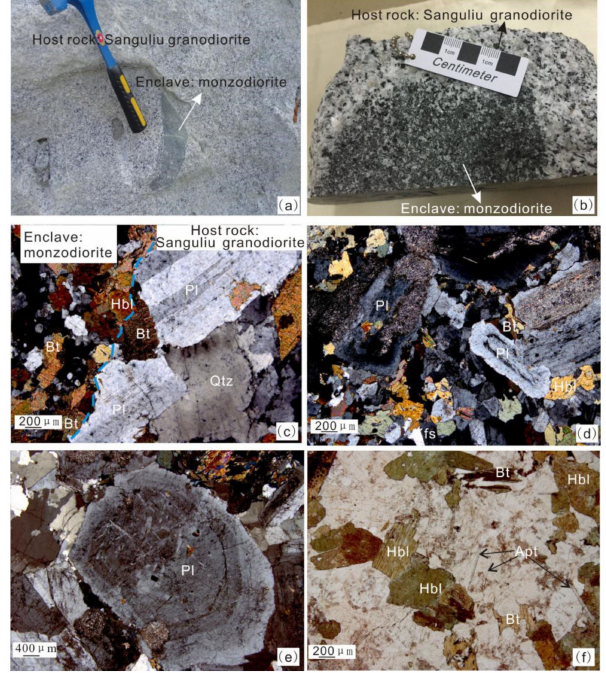
Figure 4. Photographs ( a , b ) and microphotographs ( c – f ) of the Sanguliu granodiorite and enclaves. ( a , b ) The monzodioritic enclaves occur in elliptic and marquise shape within the Sanguliu gran- odiorite; ( c ) The host granodiorite and enclave have sharp contact; ( d ) The plagioclase within the host granodiorite has zonal texture; ( e , f ) The monzodioritic enclave has plagioclase of zonal tex- ture and acicular apatite. Apl—Apatite; Bt—Biotite; Hbl—Hornblende; Kfs—Potassium feldspar; Pl—Plagioclase;